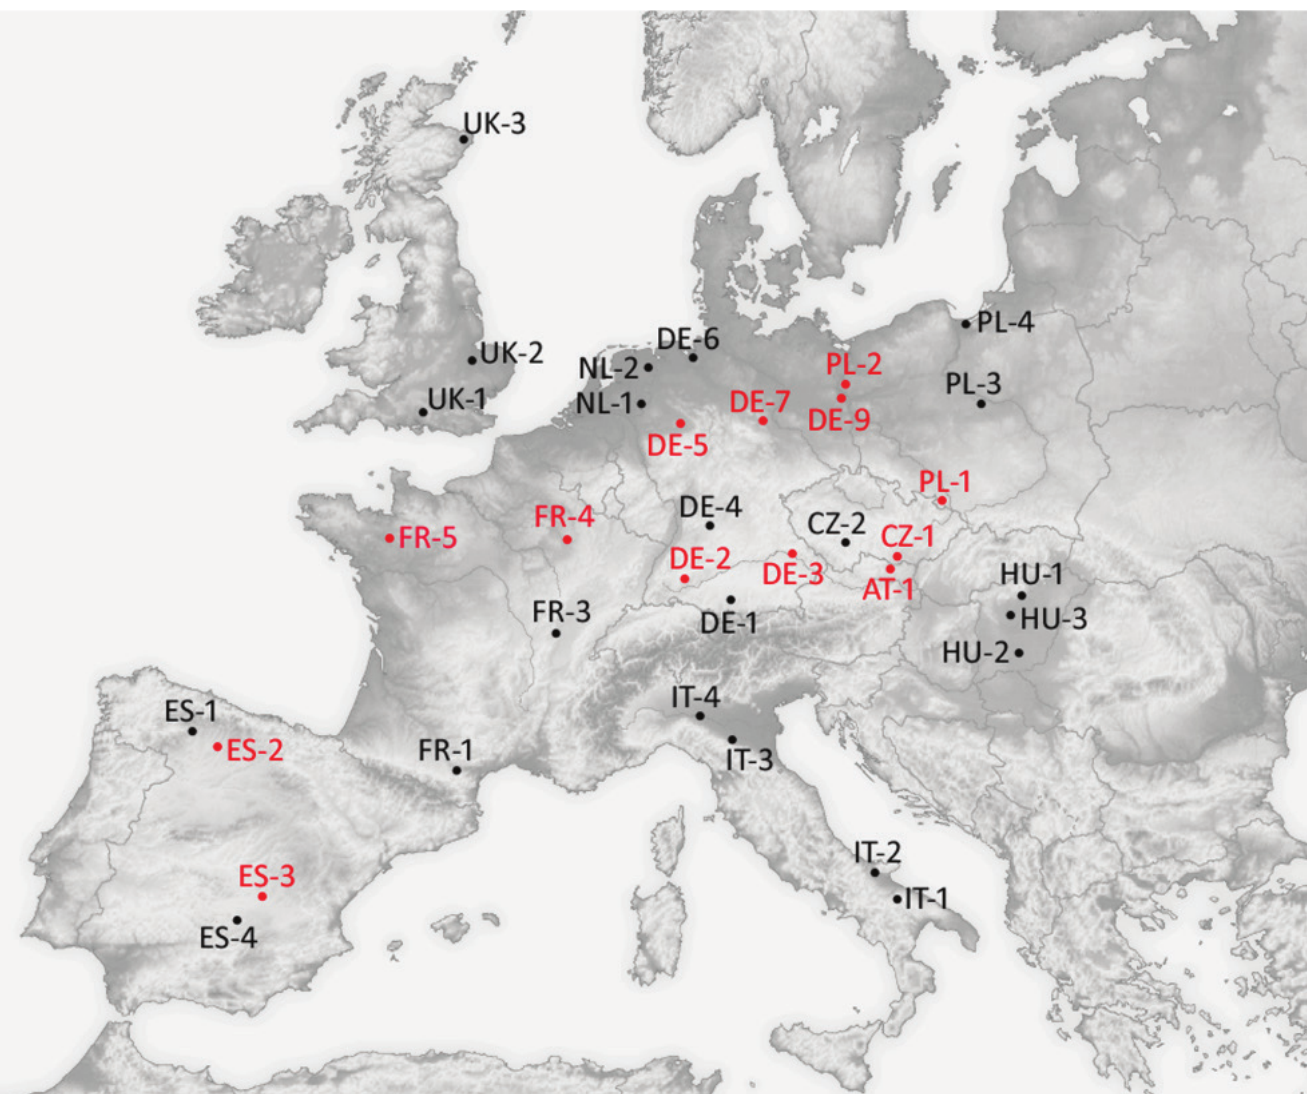
Figure 3. Map showing the study regions in 2014 and 2016 (regions re-assessed in 2016 in red). Own map based on the „Europe topography map“ by San Jose - License under CC BY-SA 3.0 Wikimedia Commons. The points locate the pilot regions (e.g. four regions in Spain ES-1, ES-2,.., ES-4; all points (red and black) indicate the 35 pilot regions assessed in 2014; the regions indicated with red points and red letters were re-assessed in 2016 while the black regions were only assessed in